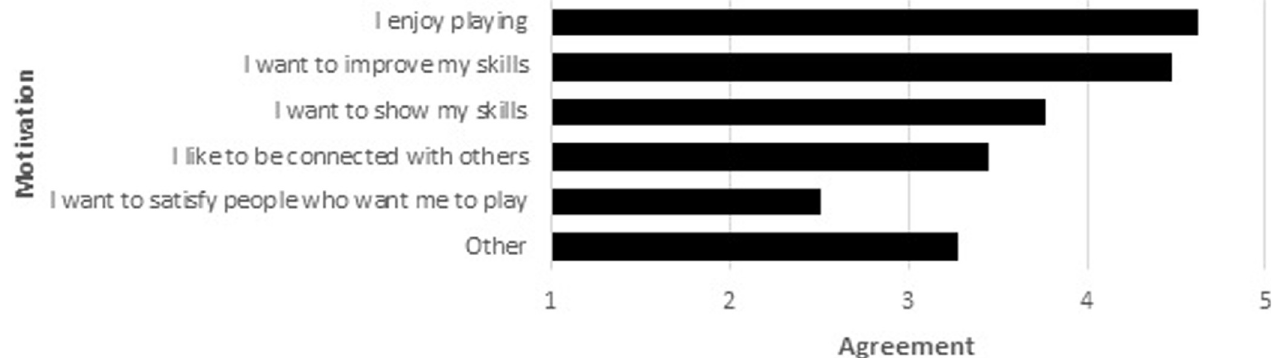
Fig 9. Motivation to play esports games. Scale: 1 –Does not apply at all, 3 –somewhat applies, 5 –fully applies.